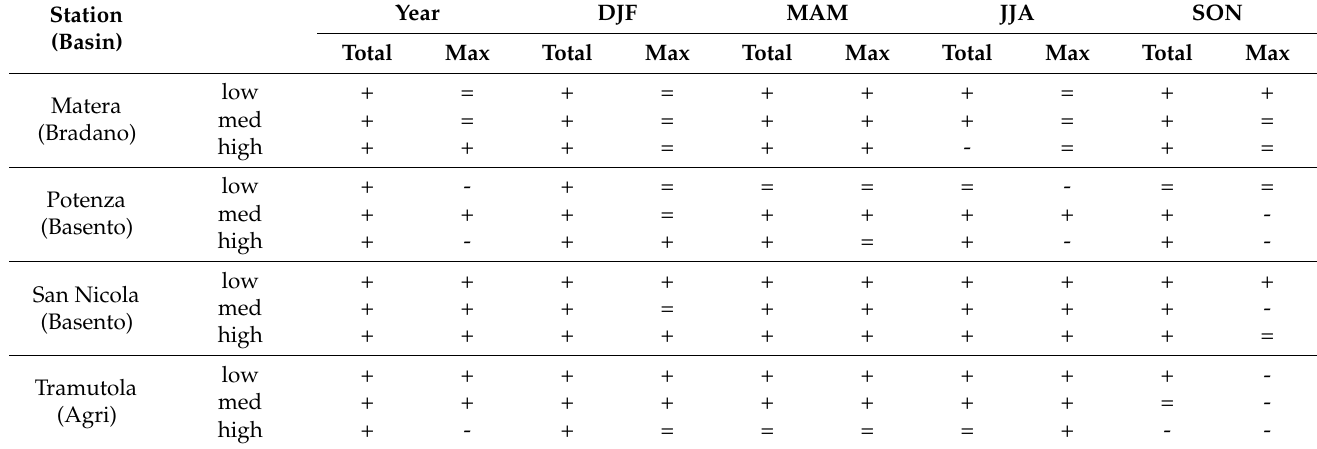
Table 1. Trends, defined with the ITA method, for annual and seasonal rainfall totals and maxima for four stations in Basilicata (related basins in brackets) and for three ranges of values (low,